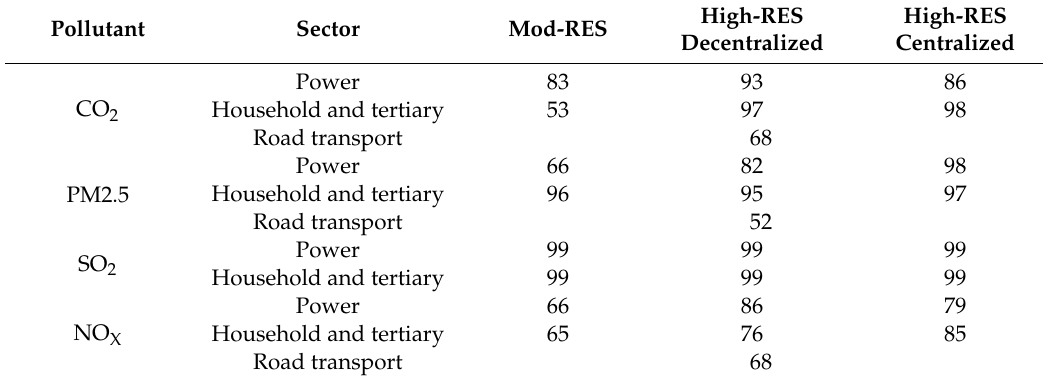
Table 1. Reduction of pollutant emission in Poland in 2050 compared to 2005 taken into account in the analyses. Data for the moderate renewable scenario (Mod-RES) and the two high renewable scenarios (High-RES), decentralized and centralized, scenarios considered in the analyses (%). Based on [19,20,35,36]. High-RES High-RES Pollutant Sector Mod-RES Decentralized Centralized Power 83 93 86 CO 2 Household and tertiary 53 97 98 Road transport 68 Power 66 82 98 PM2.5 Power 99 99 99